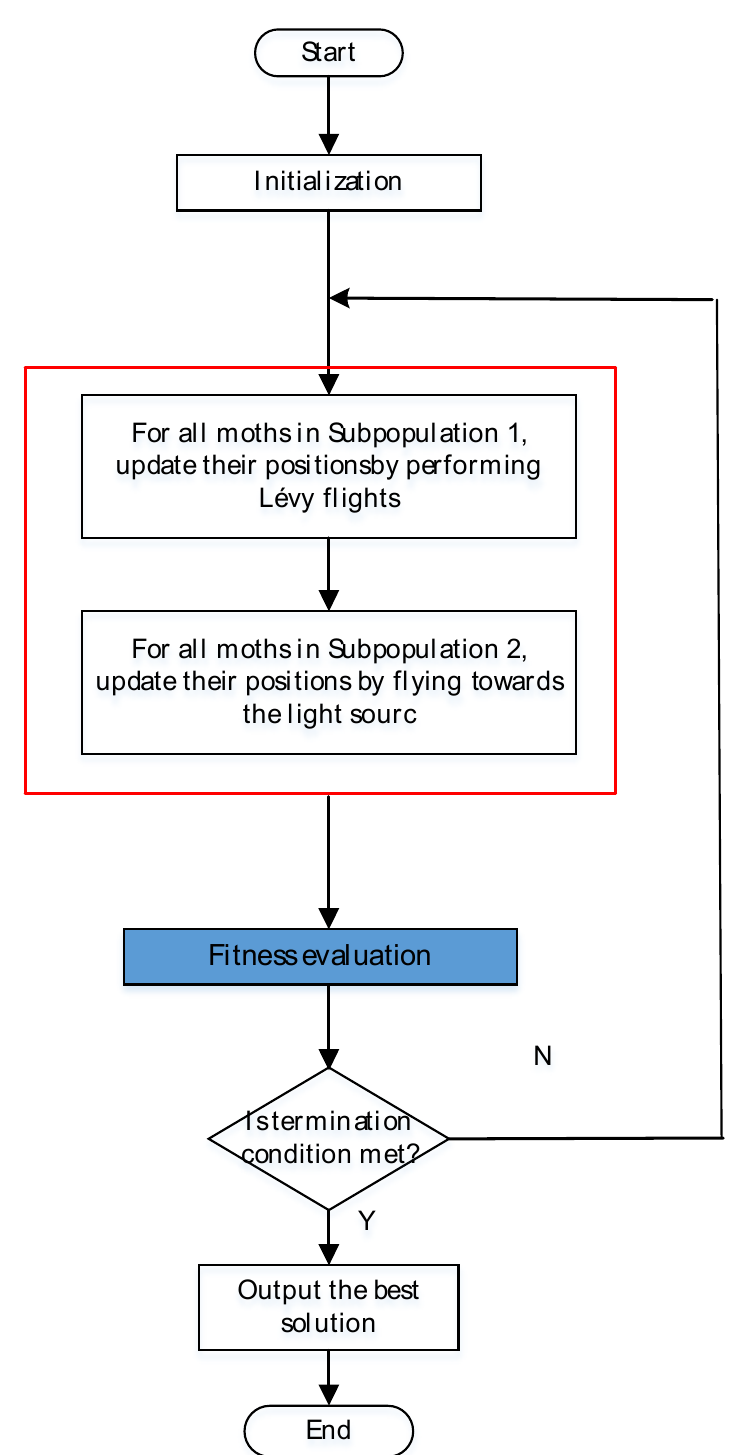
Figure 4. Flowchart of the MS algorithm.